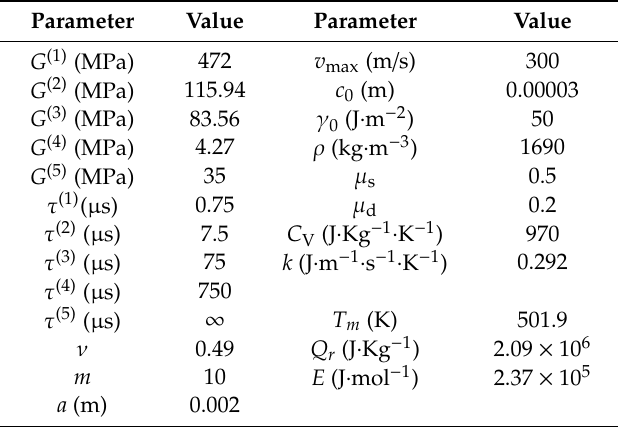
Table 1. Material parameters for